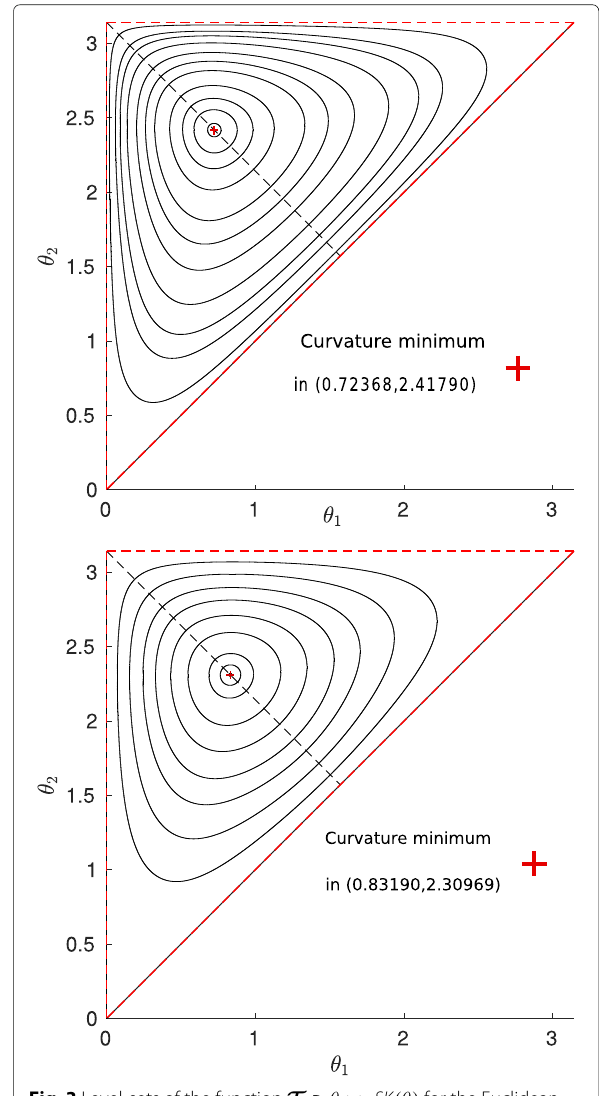
Fig. 3 Level-sets of the function T (cid:8) θ (cid:2)→ SK (θ) for the Euclidean cost (top) and the mechanical cost (bottom)